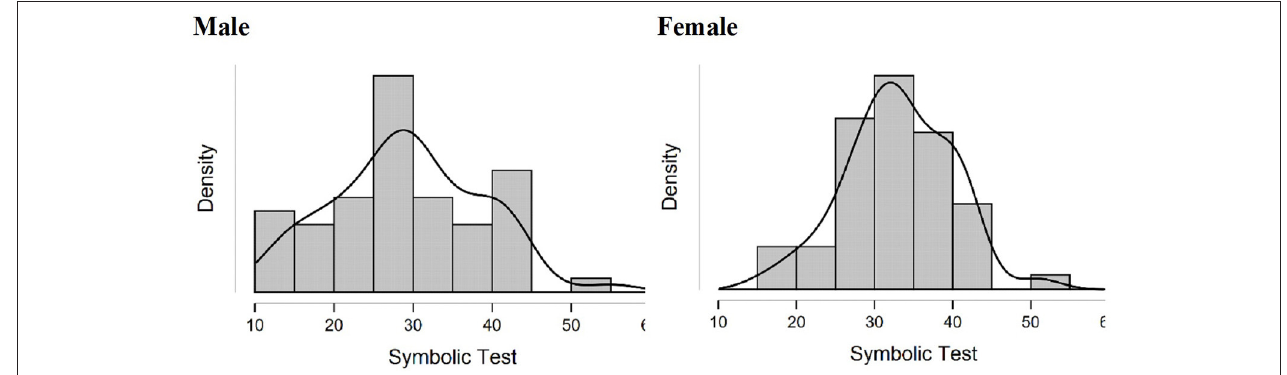
FIGURE 1 | Distribution in the Spanish language sample of third grader scores on the symbolic test by gender.